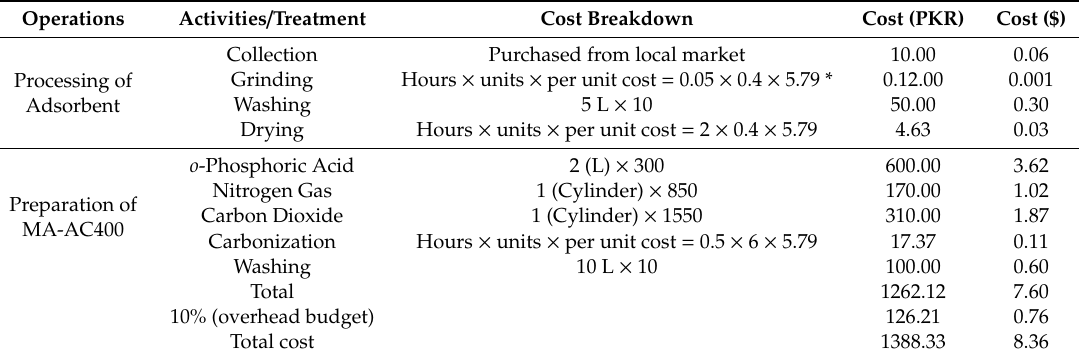
Table 5. Cost analysis of MA-AC400 production at lab scale (PKR versus USD).